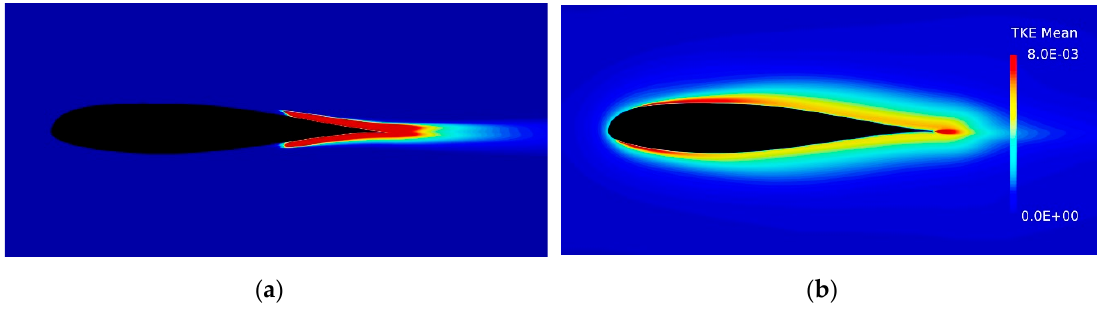
Figure 26. Mean TKE distribution. ( a ) Clean flow; ( b ) Cylinder wake